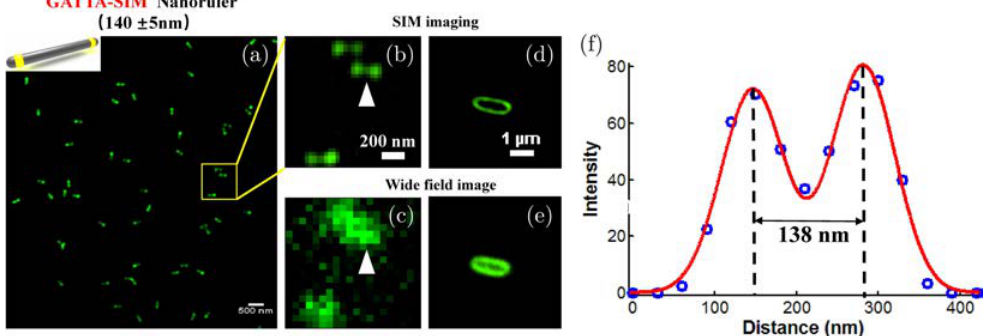
Fig. 1. (Color online) SIM and conventional °uorescence microscopy images of GATTA-SIM nanoruler and E. coli . (a) SIM image of GATTA-SIM nanorulers. (b) Enlarged SIM and (c) conventional °uorescence images of the boxed regions in (a). (d) SIM and (e) conventional °uorescence microscopy images of a representative bacterium. (f) Line pro¯le of the nanoruler image indicated by the arrowhead in (b). The blue dots show the experimental data, and the red line is for Gaussian